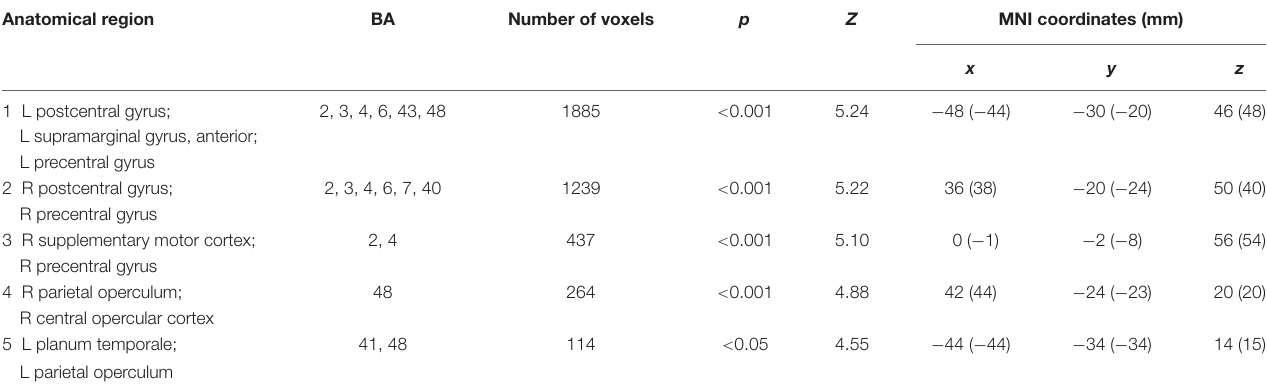
TABLE 3 | Activation clusters for the insight (solvable CRAT) < no-insight (control) contrast during the presentation of the solution. Anatomical region BA